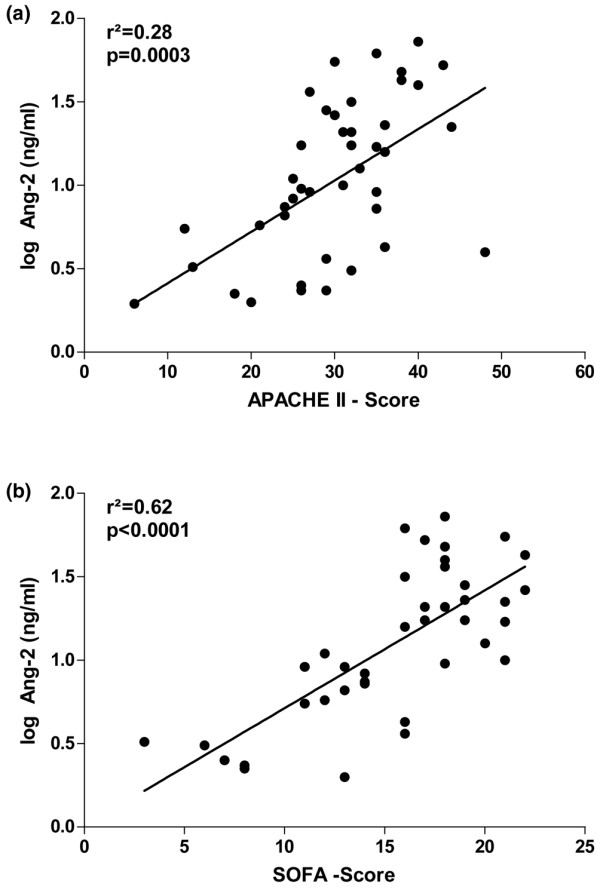
Scatter plots showing correlations of results. Correlations of Ang-2 serum concentrations with (a) the Acute Physiology and Chronic Health Evaluation (APACHE) II score and (b) the Sequential Organ Failure Assessment (SOFA) score in 43 critically ill patients (non-septic patients (n = 14); severe sepsis (n = 12) and septic shock (n = 17)).